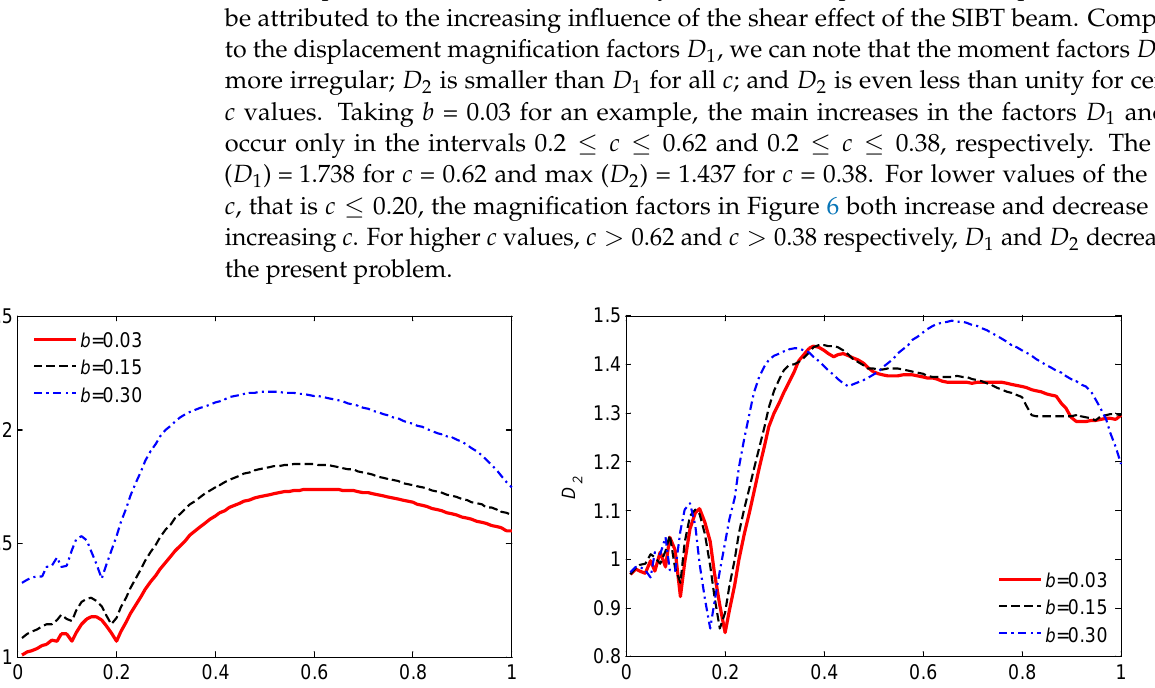
Figure 6. Dynamic magnification factors of the beam under moving load P at different speeds. Figures 7 and 8, respectively, plot the nodal time history of the normalized displace- ments and bending moments of a beam. For example, the beam with b = 0.03 is subjected to a moving load with c = 0.50. The maximum displacement of the beam is found to be y L , occurring at node 11, which locates at the mid-span, and when t = 0.66 . 1.71 ( / 2) st However, the maximum bending moment of the beam of 1.57 ( / 2) 13, which corresponds to x = 0.6 L , and when time t = 0.61 . This interesting phenomenon shows the discrepancy between the occurrences of the maximum displacement and bend- ing moment. The reason may be related to the assumption of the SIBT, which deserves further study. Figure 7. Displacement–time graph at each beam node.